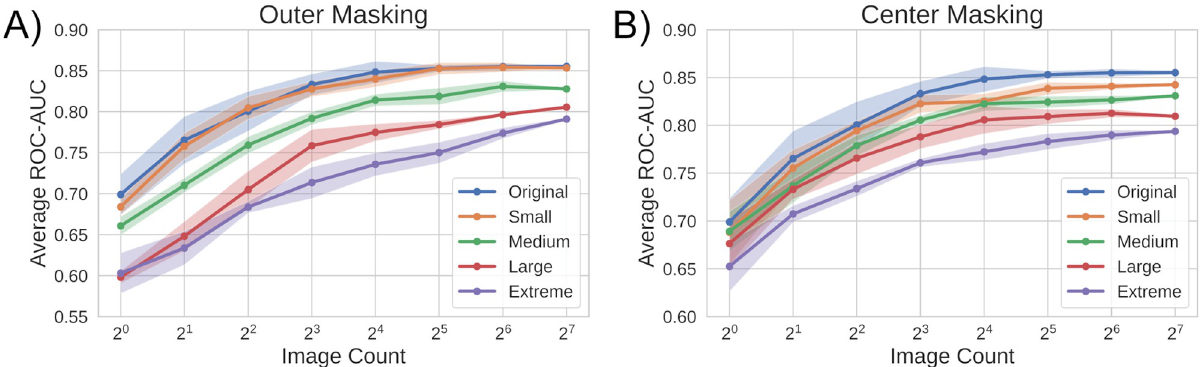
Fig 7. Results of perturbation experiments. Average ROC-AUC of screening predictions compared to the number of images (randomly selected across five trials) used to make the prediction.